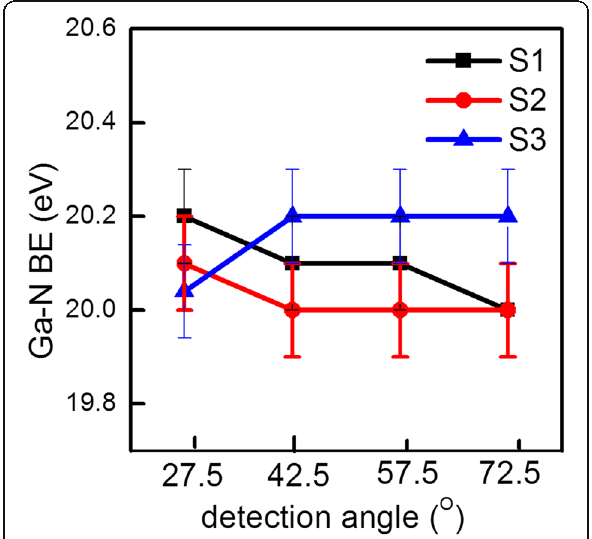
Fig. 2 The BE of the Ga – N spectrum peak as a function of the detection angle θ (relative to the normal) for S2. The error bar is ±0.1